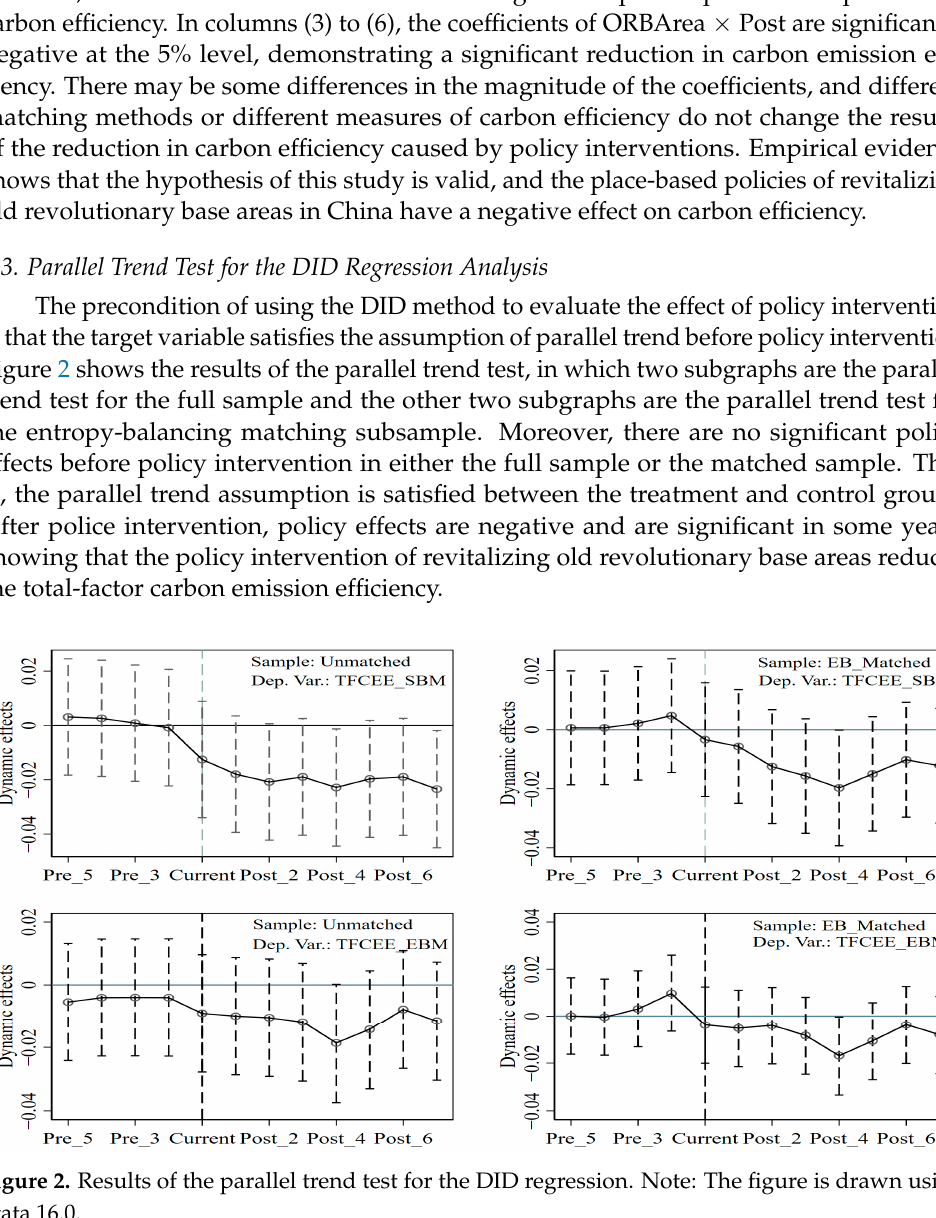
Table 7. Empirical results of factor allocation efficiency analysis.